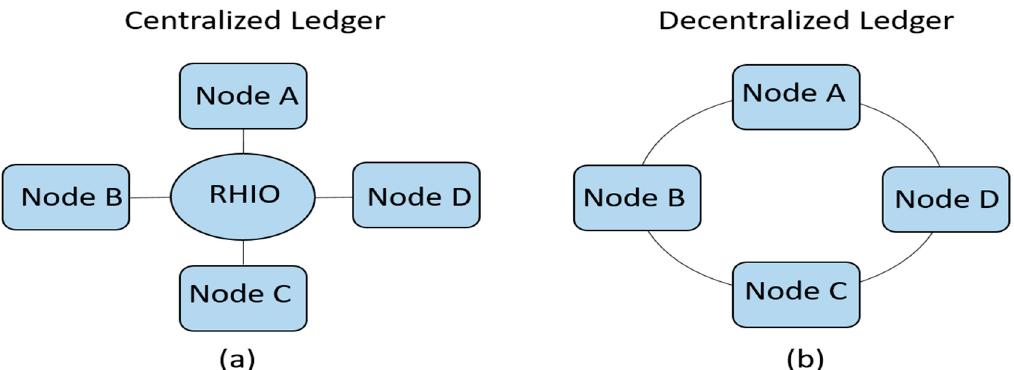
Figure 1. Centralized vs. decentralized system. In ( a ), there are multiple ledgers but all records are held in RHIO, whereas in ( b ), there is only one ledger but every node has some level of access to that ledger. The decentralized architecture removes the need for trusted third party, makes transactions faster, and removes the transaction fees charged by the trusted third party (RHIO).